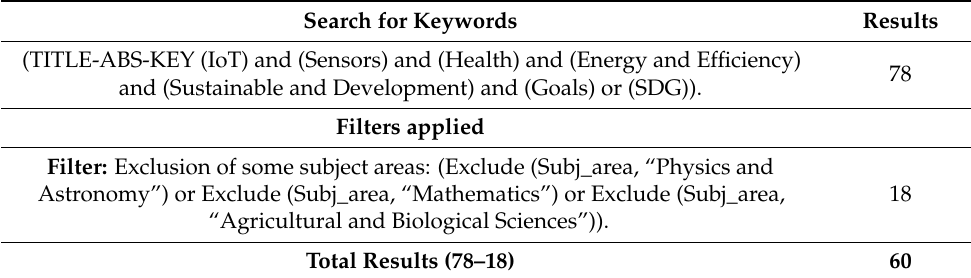
Table 2. Methodological search strategy and